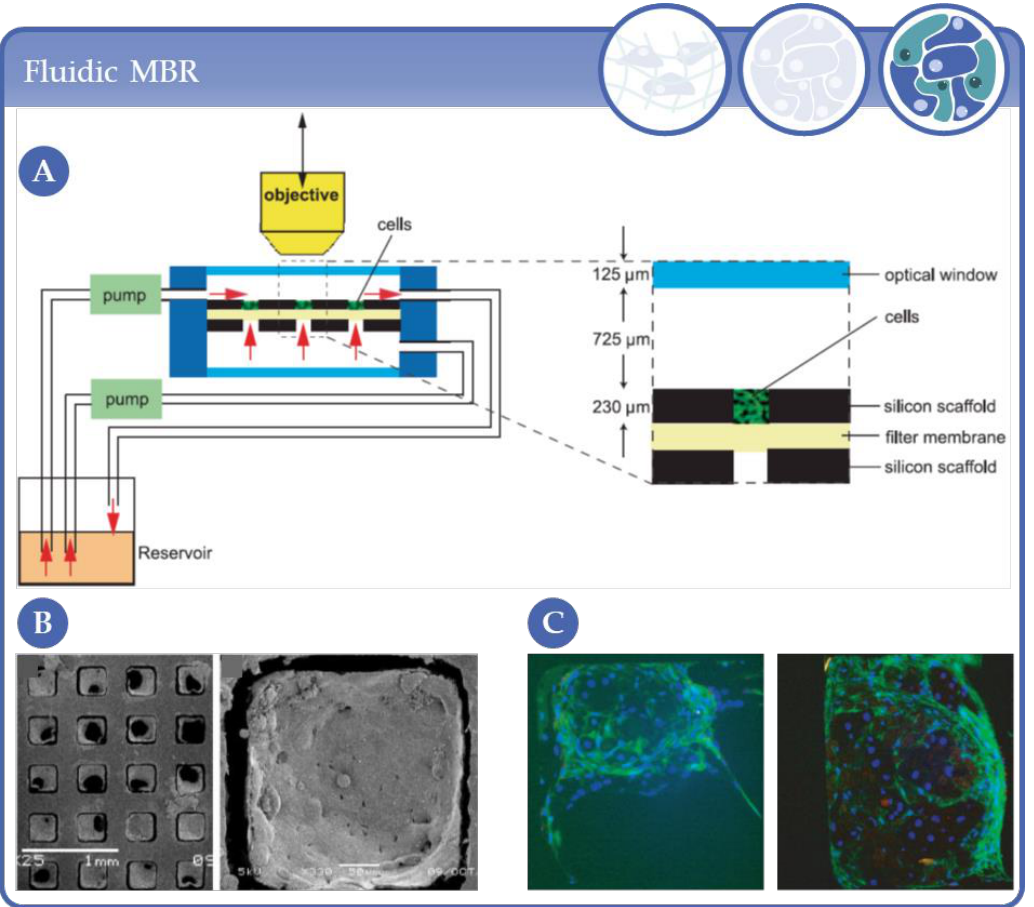
Figure 22. ( A ) Microfluidic bioreactor of Hwa et al. for both, perfusion and superfusion of cells in silicon scaffolds. The optical window allows for microscopy during experiments. ( B ) SEM of 3-day old microreactor co-cultures or rat liver sinusoidal endothelial cells with hepatocytes. ( C ) Immunohistochemistry of the co-cultures. Reprinted from [174] with permission of John Wiley and Sons.